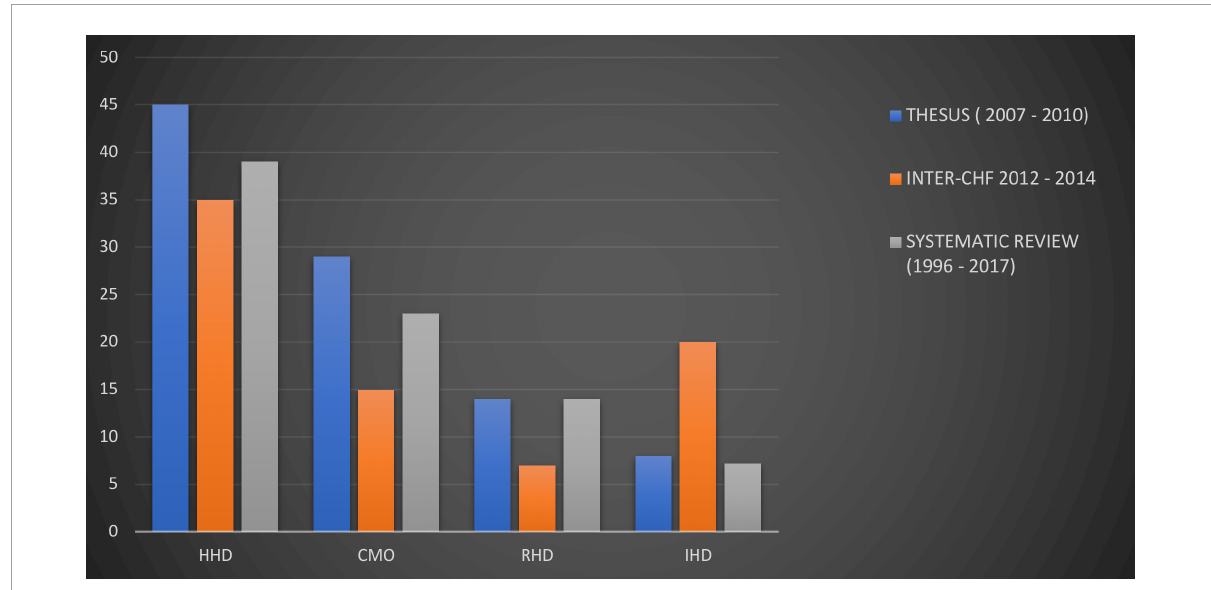
FIGURE3 Trends in heart failure etiologies in Africa derived from heart failure cohorts from two different time spans (Thesus-HF and INTER-CHF Africa) and a systematic review (15, 45, 47). HHD, hypertensive heart disease; DCM, dilated cardiomyopathy; RHD, rheumatic heart disease; IHD, ischemic heart disease. CMO compiled as a combination of reported cardiomyopathies, idiopathic dilated, peri-partum, HIV-associated.